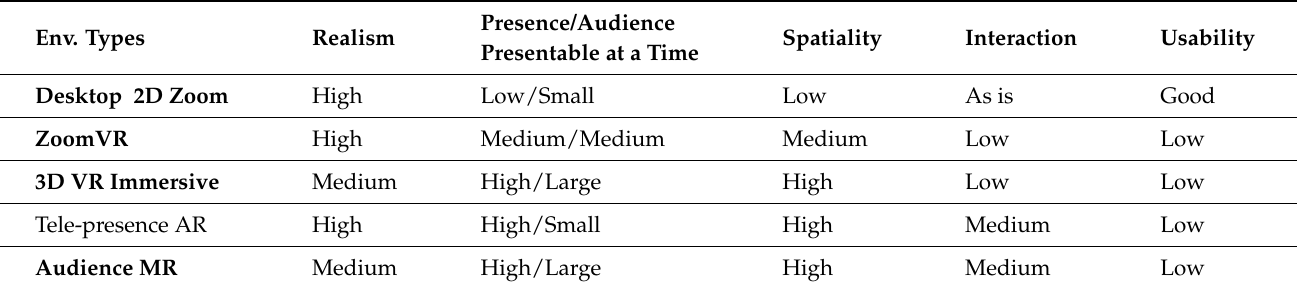
Table 2. Possible environment types to achieve presence of large audience and crowd and their characteristics. Environment types written in bold are compared in the validation experiment. Env.